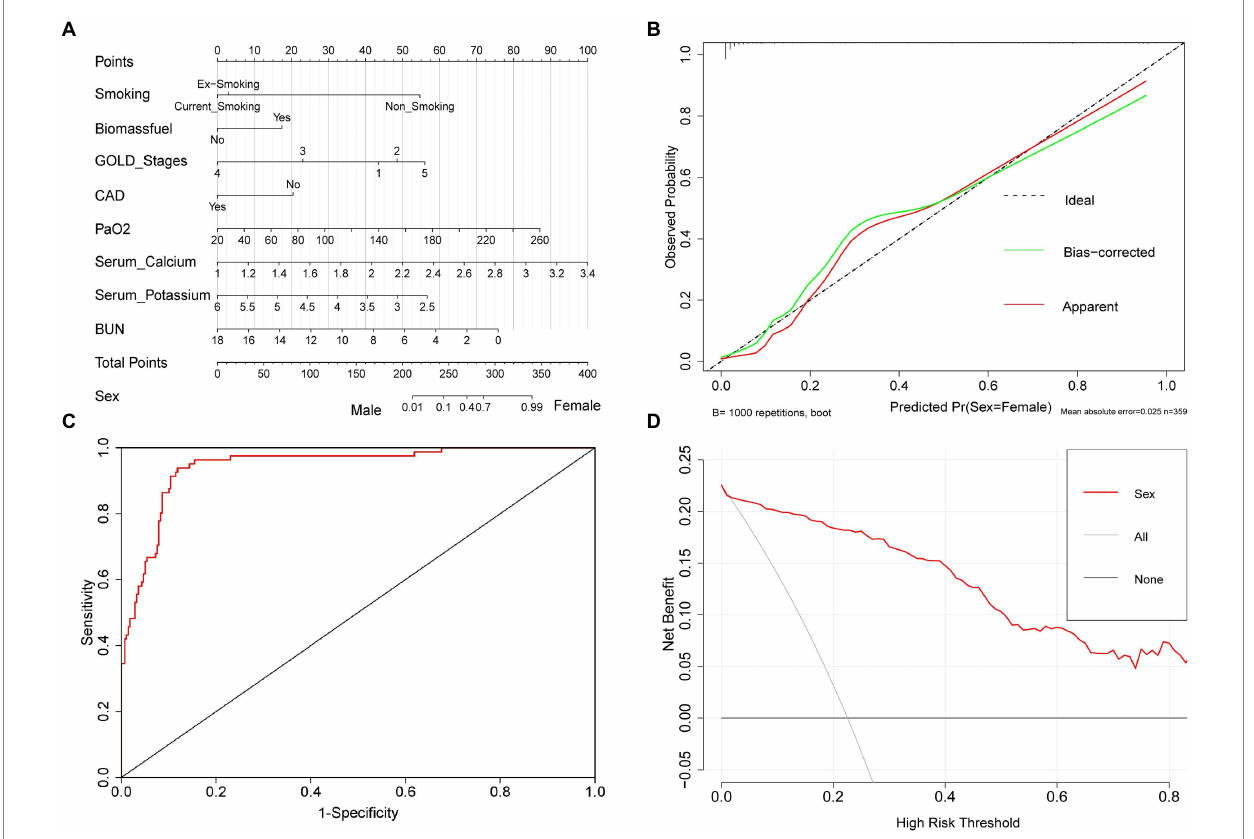
FIGURE 3 The nomogram for predicting sex in patients with AECOPD. Nomogram was used to visualize and validate the binary logistic regression model. (A) Nomogram. The total point of a specific patient is the sum of individual variable points. The predicted probability of sex is on the sex scale, which is corresponding to the total points scale. (B) Calibration curve. Ideal line: The nomogram reference line; Apparent line: The actual probability of each patient in our study; Bias-corrected line is adjusted by bootstrap with 1,000 resamples. The length of the vertical lines at the top of the plot represents the number of patients. (C) ROC curve. (D) DCA curve. None line: the assumption that all patients were men. All line: the assumption that all patients were women. Red line: the